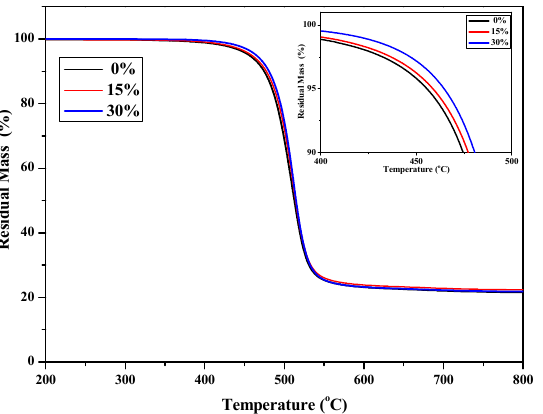
Figure 4. The TG curves of cured P(4-MB-co-1-MP) and P(4-MB-co-1-MP)/DVS-BCB resins.